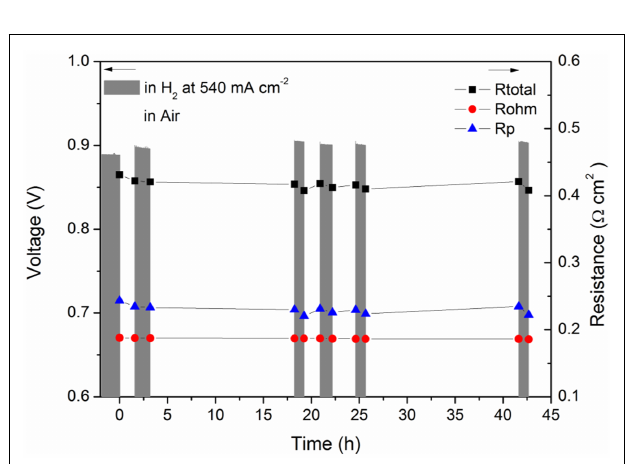
FIGURE 13 | Cell voltage and resistance of Sr 1.9 Fe 1.4 Ni 0.1 Mo 0.5 O 6– δ –SDC anode versus time during redox cycling (Xiao et al., 2014) . Reprinted with permission ofThe Electrochemical